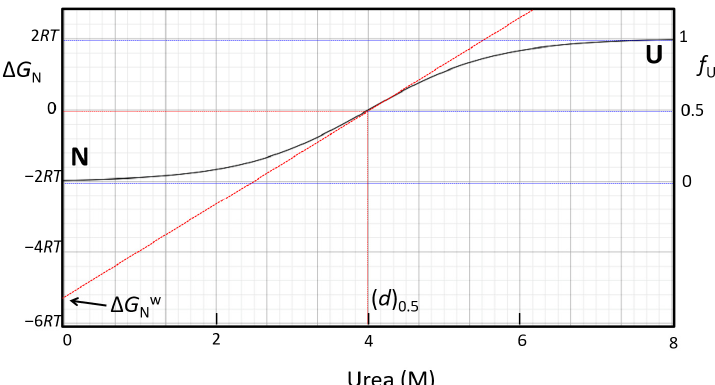
Figure 8. Estimation of the net stability of proteins, Δ G Nw , by linear extrapolation to zero concentra- tion of denaturing agent, d .